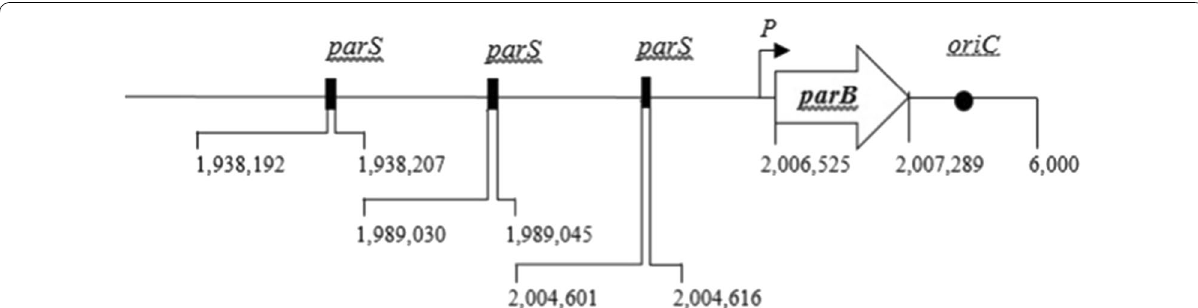
Fig. 1 Schematic diagram represents genetic organization of Streptococcus suis nucleoid segregation machinery. Locations of parB and smc genes (white block arrows), parS (black rectangles), putative promoter ( P ), and oriC (black circles) were shown. The digits below the figure indicated the number of nucleotide sequence in base pairs